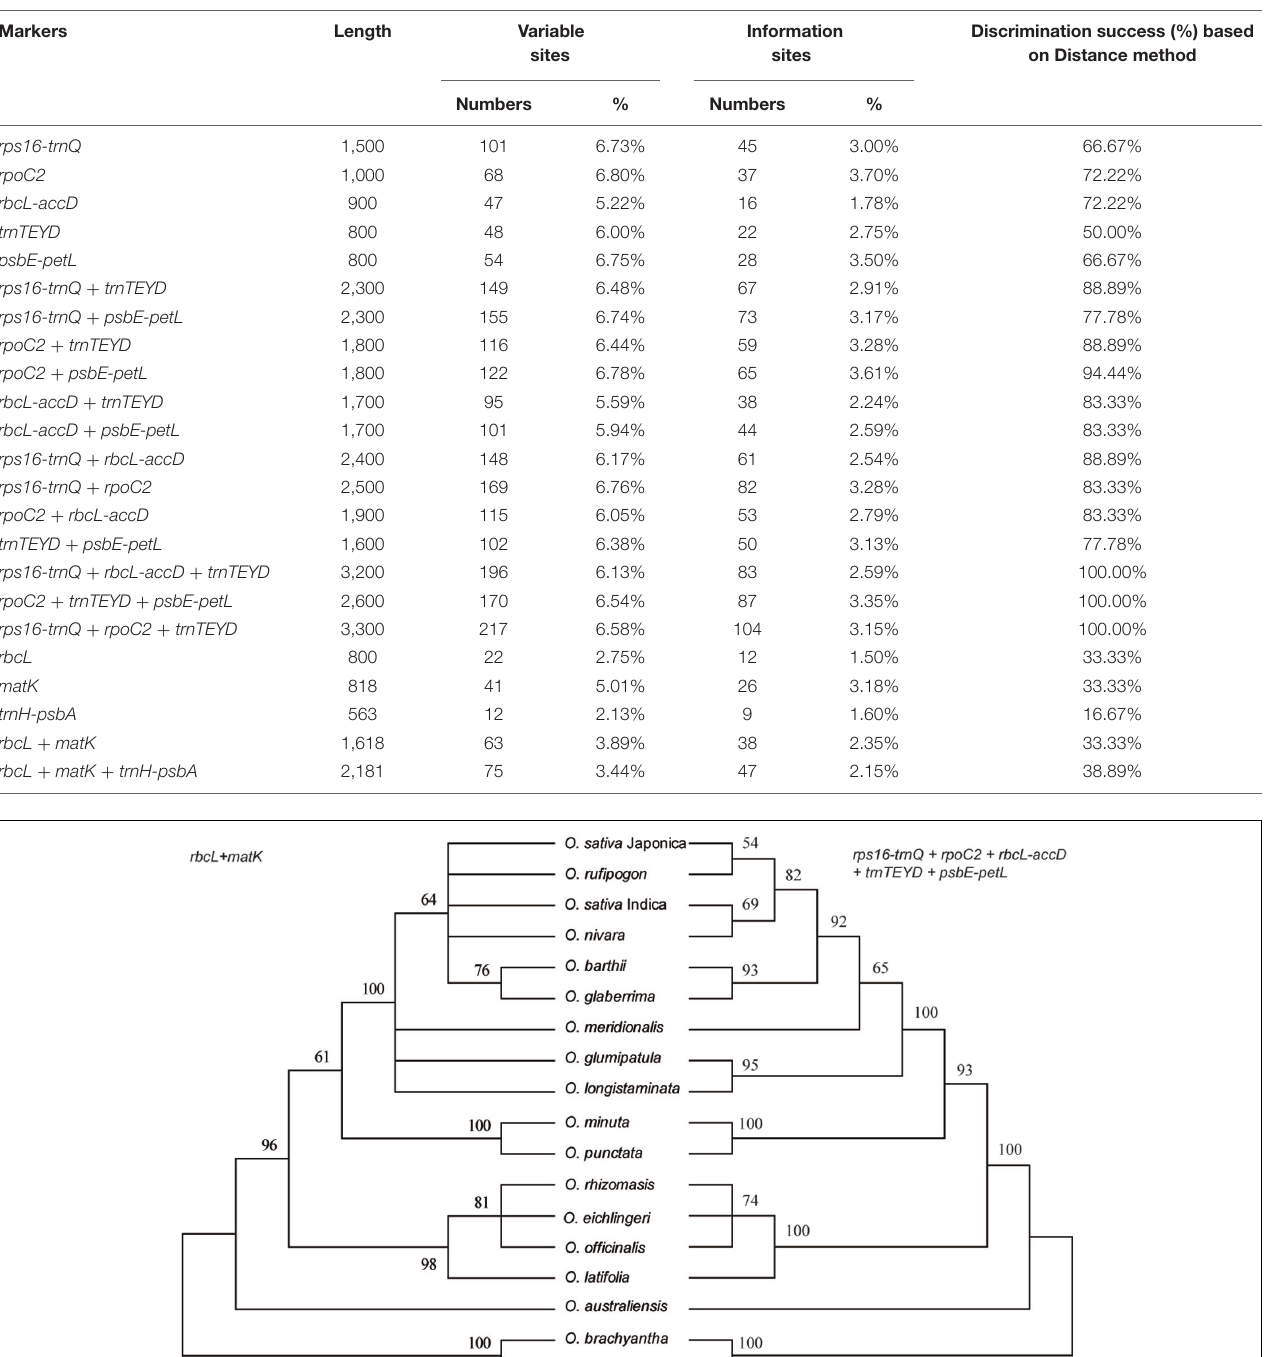
TABLE 3 | Variability of the five new markers and the universal chloroplast DNA barcodes in Oryza. Markers